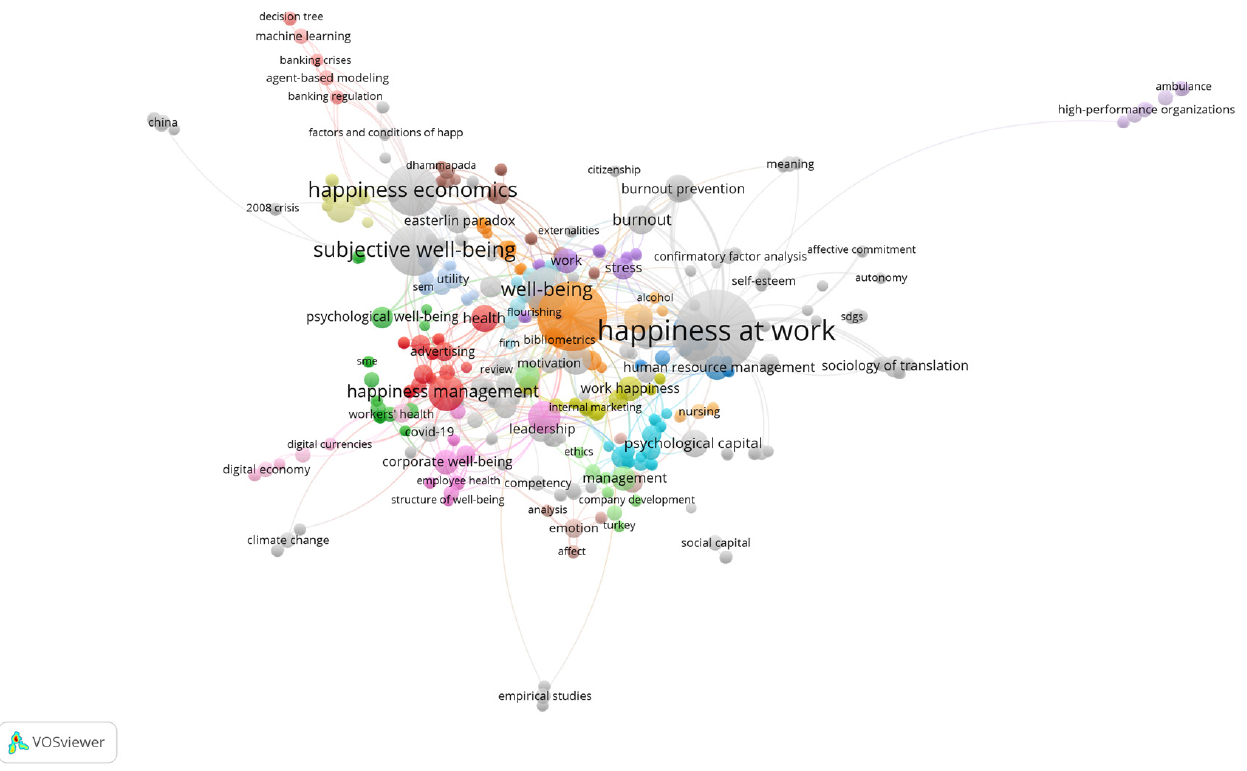
Figure 3. Keyword co-occurrence